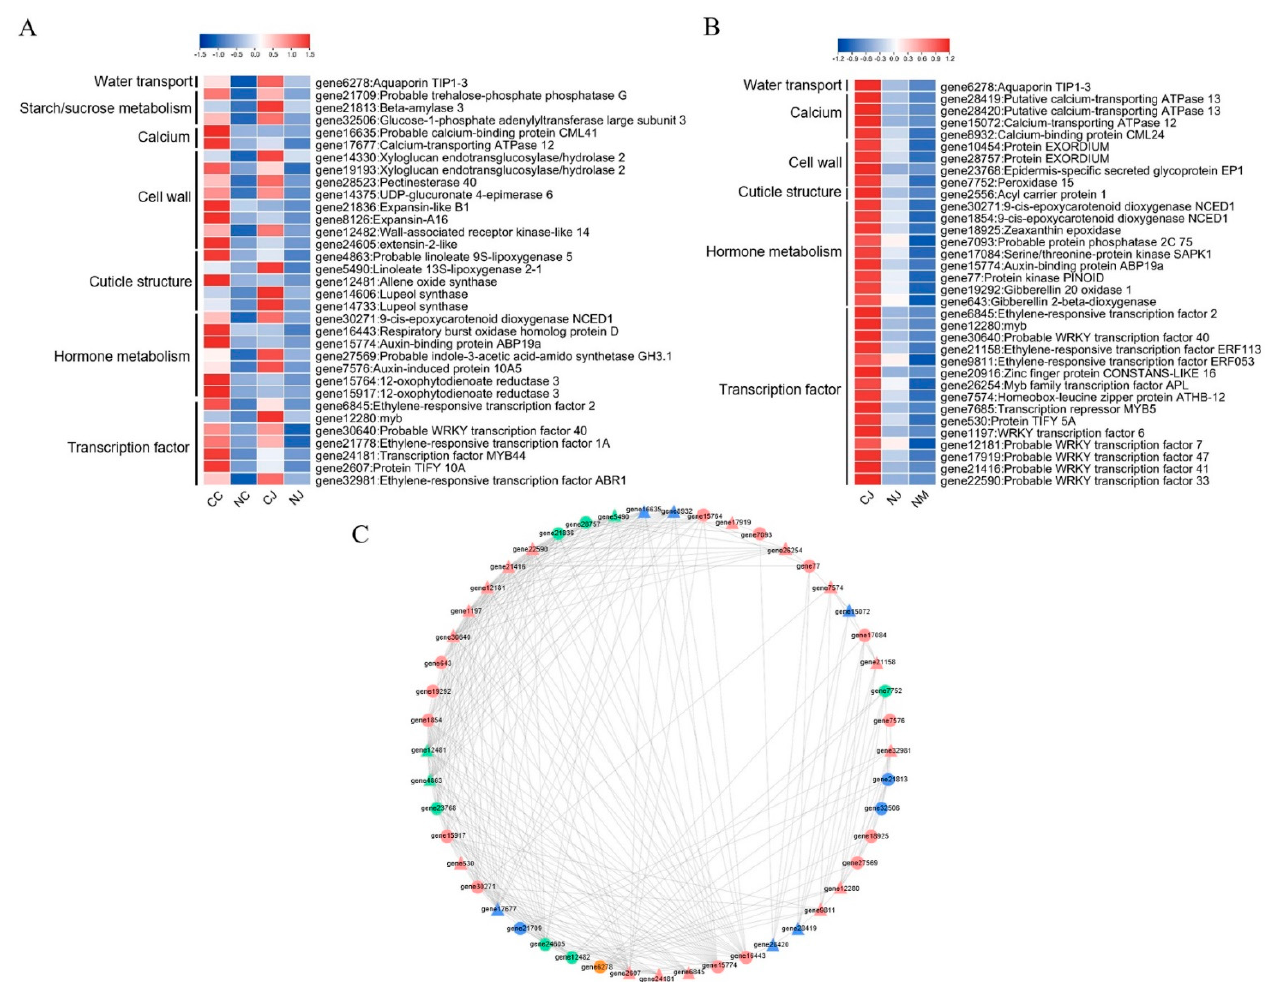
Figure 7. Co-expression of cracking-related genes. Heatmaps of the expression of candidate genes related to fruit cracking in two cracking-susceptible cultivars ( A ) and in cracking-susceptible and -resistant cultivars ( B ). ( C ) Network representation of cracking-related genes (orange circles: water transport, green circles: cell wall, blue circles: starch and sucrose metabolism, pink circles: hormone metabolism, green triangles: cuticle structure, blue triangles: calcium, pink triangles: transcription factor). Nodes represent genes, and edges represent relationships between any two genes. Edges represent positive correlations as determined by a Spearman correlation coefficient > 0.7.